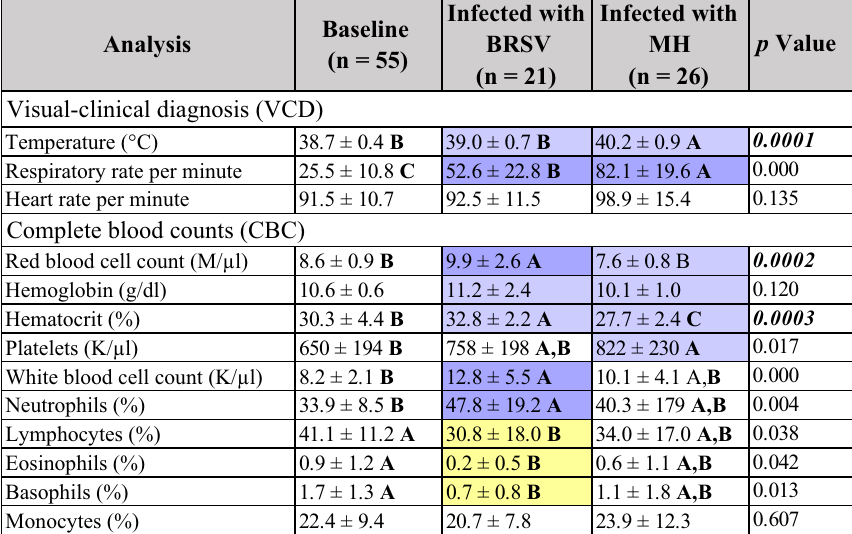
Table 2. Clinical and hematological values (Mean ± SD) for dairy calves challenged with BRSV and M. haemolytica (MH). Values with different letters were significantly different as determined by ANOVA ( p < 0.05) between categories, with a significant increase (dark purple) or decrease (dark yellow) compared to the Baseline. Values positively correlated in the PCA during infection (light purple) compared with the Baseline. Italic = parameter changed in the ANOVA and the PCA, M/µl = Millions per microliter, g/dl = grams per deciliter, K/µl = thousands per cubic